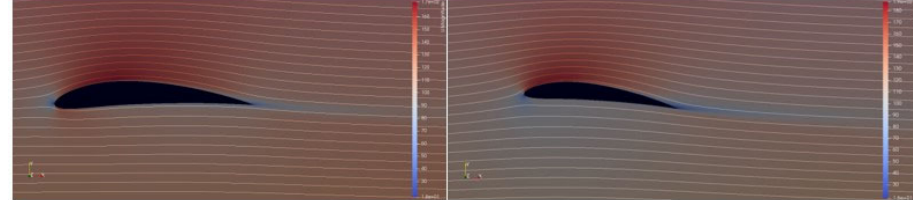
Figure 6. Contour map of the flow velocity (122 m/s) of the NACA 6412 profile from the left: for a zero and a five-degree angle of attack of the profile.